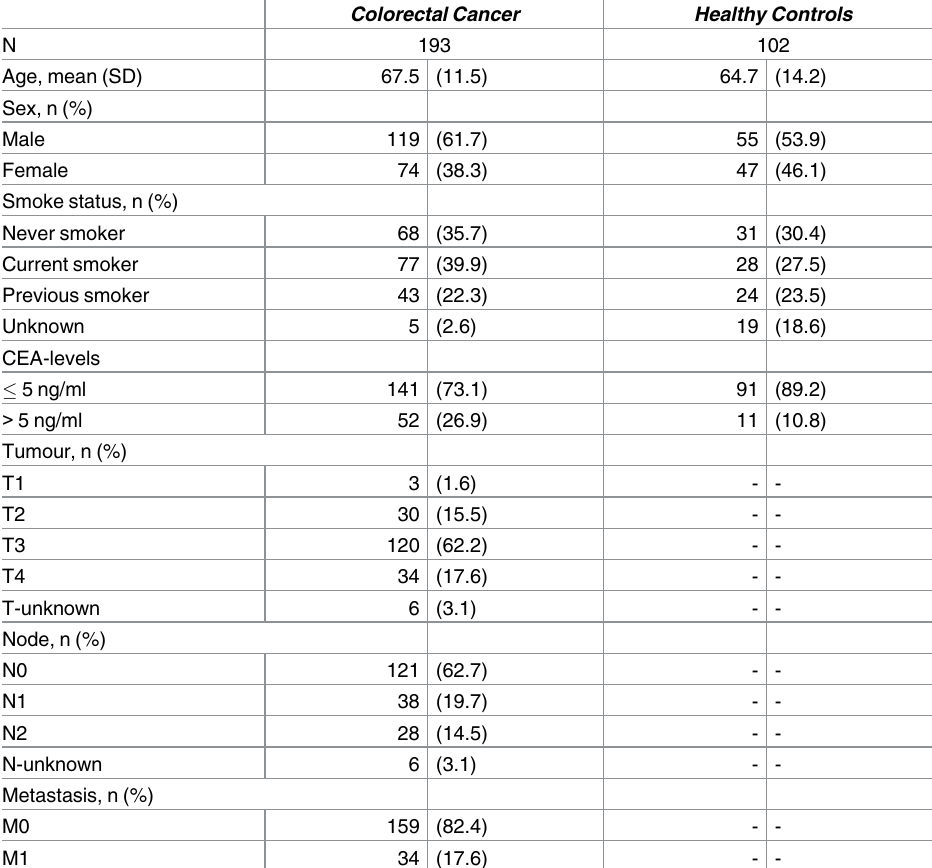
Table 1. Patient